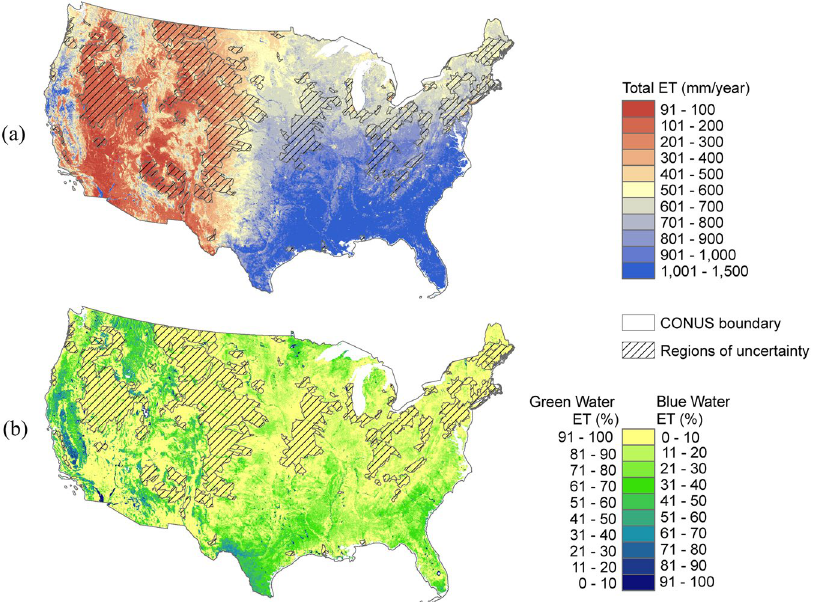
Figure 2. Long-term (2001–2015) average estimates of ( a ) annual evapotranspiration (ET), ( b ) GWET and BWET contributions (%) to the total ET for the conterminous United States. The figure was generated using ArcGIS (ArcMap 10.3.1) software